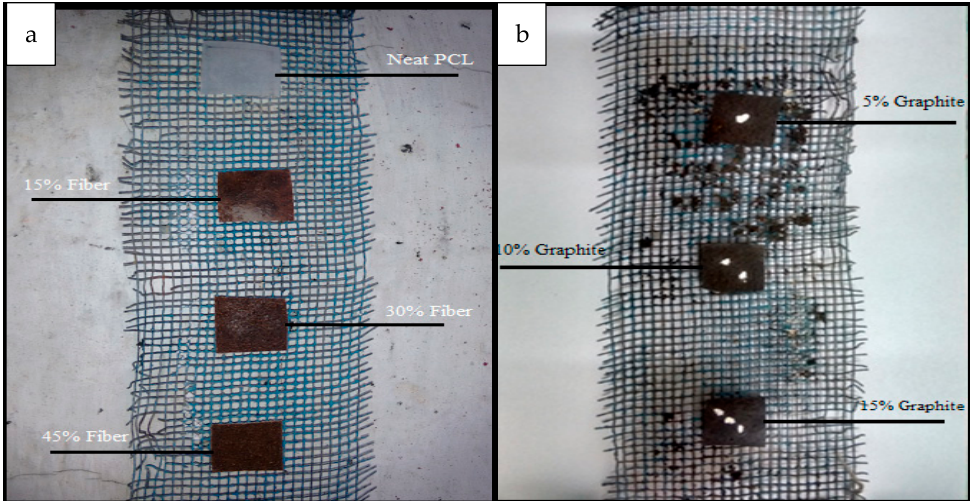
Figure 4. Mounting of bio-specimen on wire gauge ( a ) for unmodified matrix, ( b ) Modified matrix with graphite content.